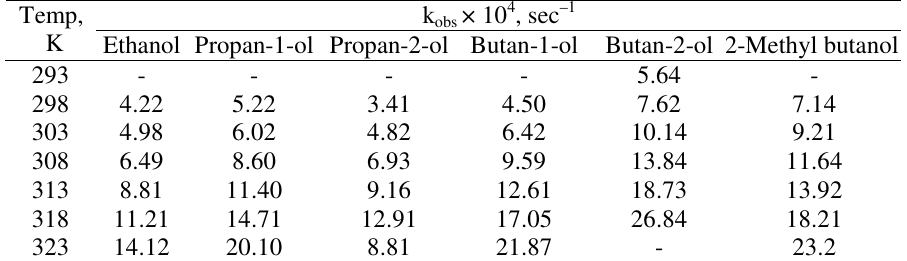
Table 5. Thermodynamic parameters for various